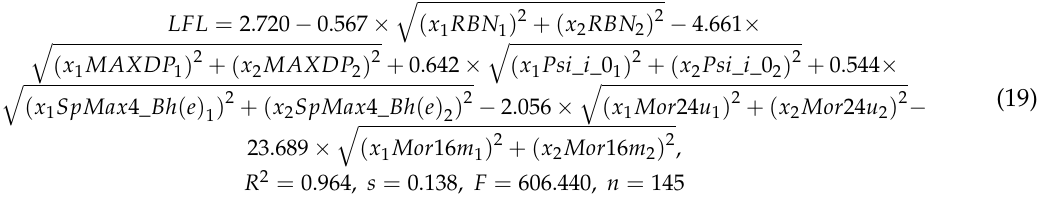
Figure 2. Performance comparisons of the QSPR models for the LFLs of mixtures depending upon the types of mixture descriptors.